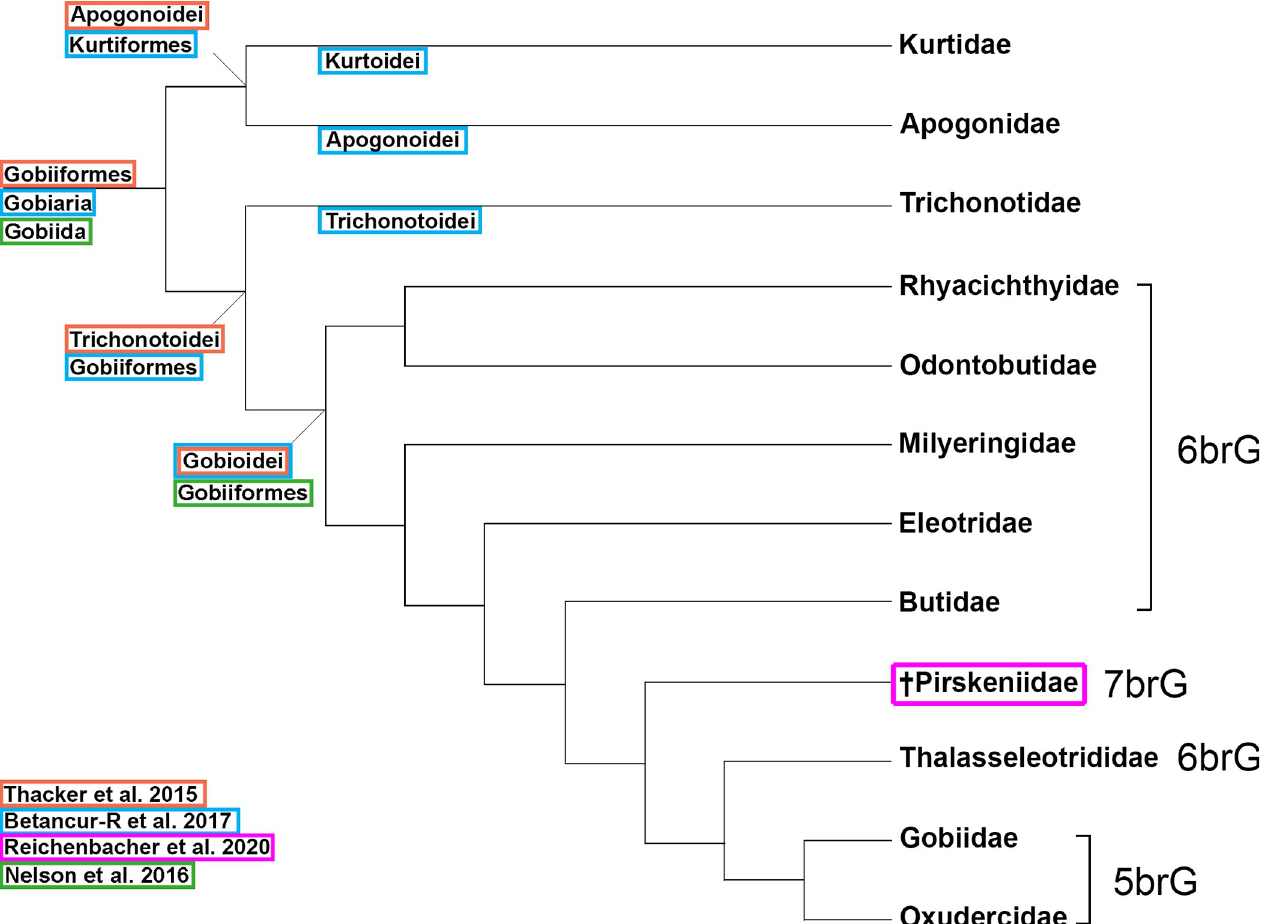
Fig 1. Current understanding of gobioid relationships showing the different nomenclatures in use. brG = branchiostegal-rayed Gobioidei.